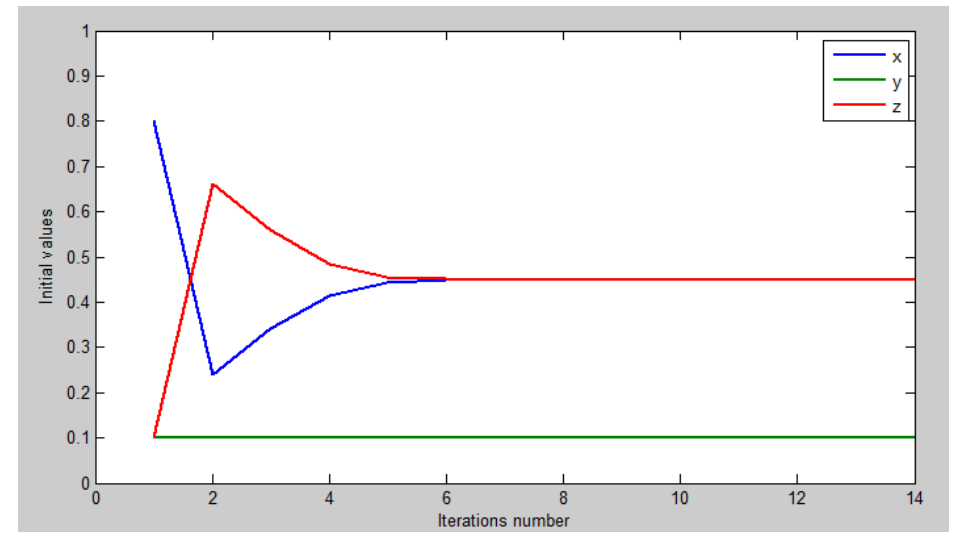
Fig. 2. The trajectory of operator V 2